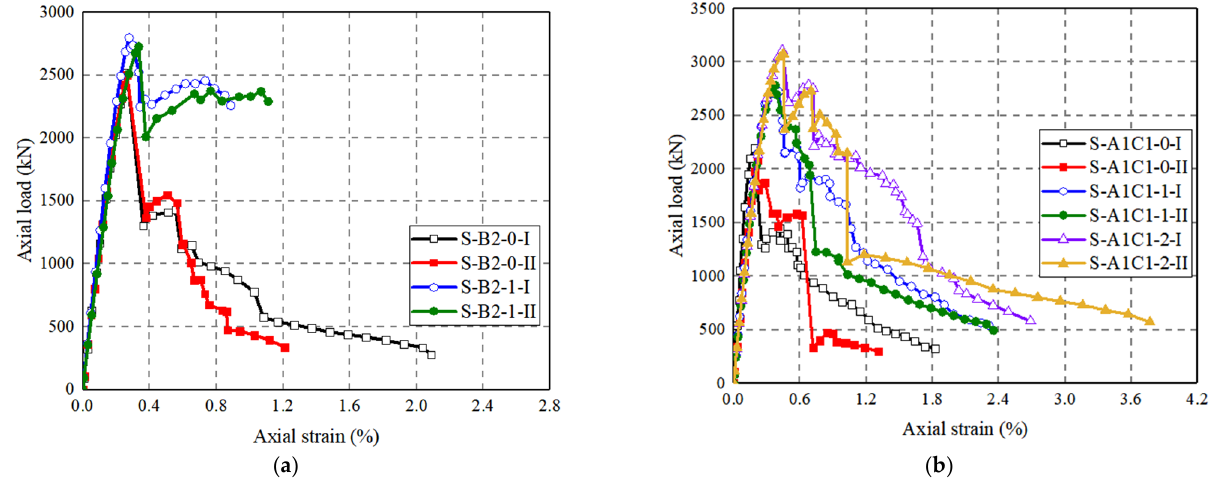
Figure 13. Effect of number of the external CFRP wrap. ( a ) Position B; ( b ) Position AC.